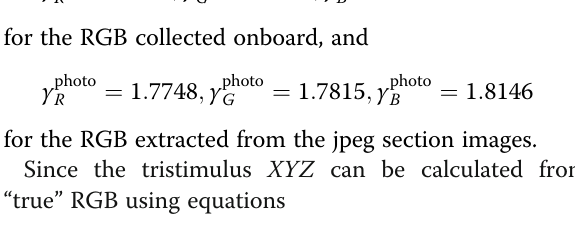
Inter-calibration of RGB values and RSC data between JOIDES Resolution (JR) and KCC For the patched interval from 1.22 to 1.53 m CCSF-D, the corresponding interval from the Core U1424C-1H was used to amend the data. Since physical properties for Cores U1424C-1H, 2H, and 3H were measured at KCC after Exp. 346, the RGB values were extracted from the digital images taken by the core scanner at KCC, and L*, a*, and b* (and tristimulus XYZ) values were transformed from those measured by the spectropho- tometer used at KCC. In order to establish inter- calibration between data taken onboard at JR and those from KCC, we first construct peak by peak matching be- tween B splice profile and B values extracted from digital images of Cores U1424C-1H, 2H, and 3H as shown in Fig. 6. Then, RGB and XYZ data for corresponding stratigraphic positions were compared between the splice data taken onboard and U1424C data taken at KCC (Fig. 7). Figure 7a – c shows that RGB do not JR converge to zero when RGB get close to zero. This is KCC probably due to the difference in sensitivity of scanners under very dark condition. Therefore, the transform- ation of RGB data from KCC values to JR ones requires the form of power function with bias factors a